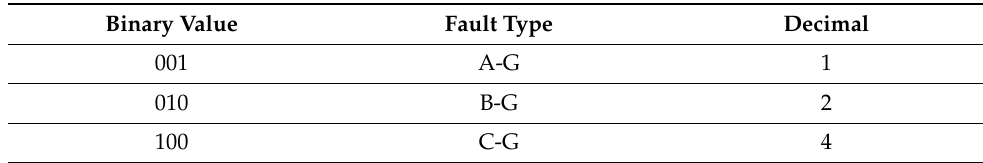
Table 4. Selecting fault type in